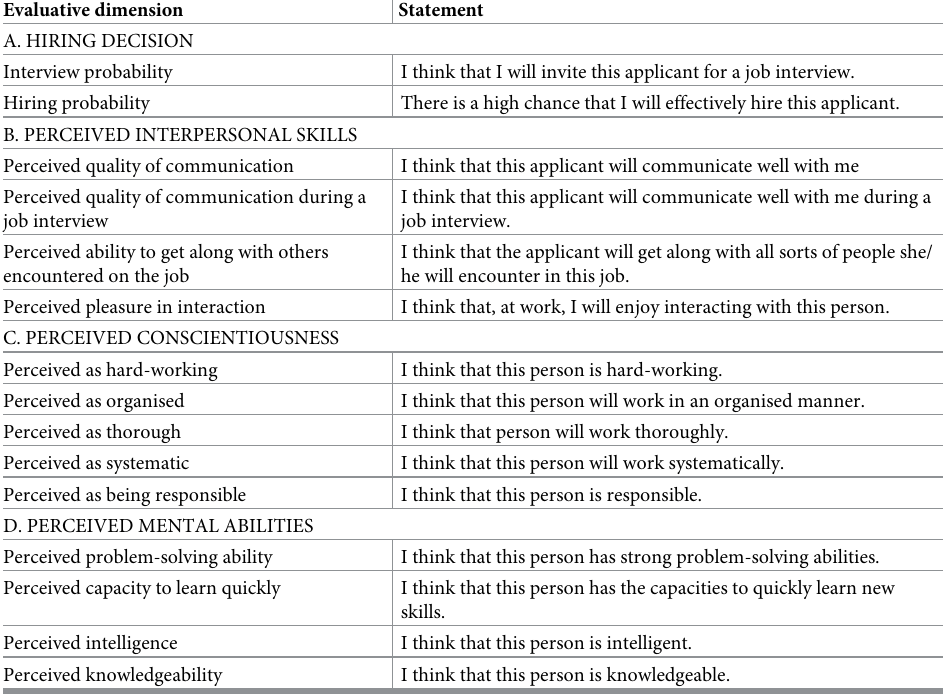
Table 3. Items used for applicant